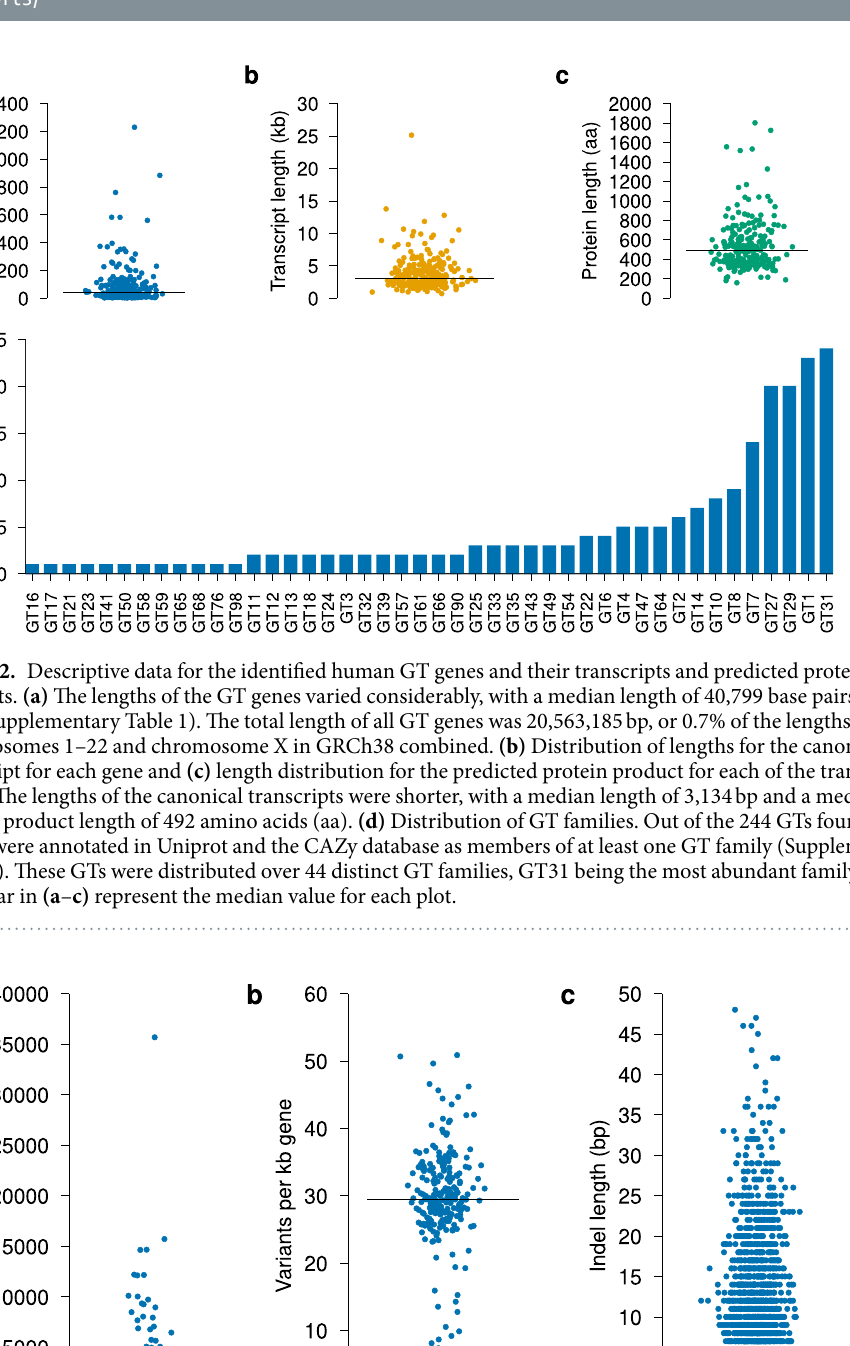
(Table 2). Notably, 16 of these had variants in 1000 G predicted to cause null alleles (Table 2, Supplementary Table 4). Homozygosity or compound heterozygosity for these alleles could result in a null phenotype and poten- tially the absence of a glycan cell surface antigen (Fig. 5). Furthermore, 29 genes (excluding ST6GAL1 ) had vari- ants classified as having moderate impact. Among these variants, we found variants classified to be damaging and deleterious by the PolyPhen-2 and SIFT tools, respectively, potentially disrupting protein function. To find even more rare null alleles, not represented in 1000 G, we searched the Genome Aggregation Database (gnomAD) 34